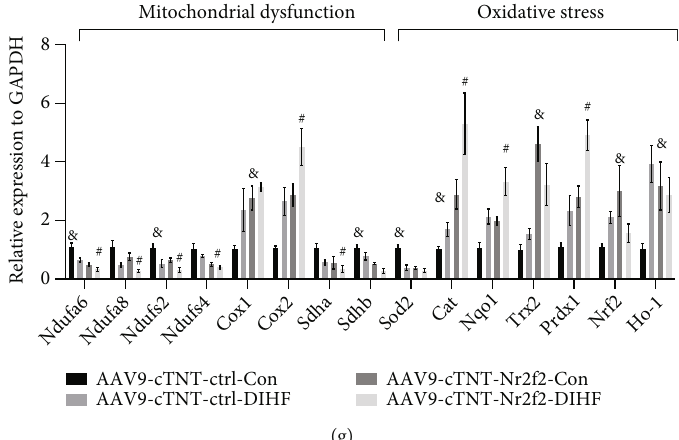
Figure 2: Overexpression of Nr2f2 aggravated cardiac ferroptosis. (a) Representative Western blot of PTGS2 and GPX4 ( n = 4 , means ± SDs , ∗ p < 0 : 05 and ∗∗∗ p < 0 : 005 , ns: not signi fi cant, two-way ANOVA). (b) 4-HNE staining (scale bar = 50 μ m ) and mitochondrial transmission electron microscopy (scale bar = 2 μ m ) were identi fi ed in the heart tissue. (c – e) Tissue MDA, GSH, and SOD levels in each group ( n = 6 , means ± SDs , ∗ p < 0 : 05 and ∗∗∗ p < 0 : 005 , two-way ANOVA). (f) Total iron level in each group ( n = 6 , means ± SDs , ∗∗ p < 0 : 01 and ∗∗∗ p < 0 : 005 , two-way ANOVA). (g) Relative gene expression of mitochondrial function and oxidative stress ( n = 6 , means ± SDs , ∗∗ p < 0 : 01 and ∗∗∗ p < 0 : 005 ; ns: not signi fi cant, two-way Con mice (Figures 1(a) and 1(b)). Nr2f2 overexpression (Figure 1(c)) had no e ff ect on fasting blood glucose and body weight in DIHF or Con mice (Figures 1(d) and 1(e)). Car- diac function, re fl ected by decreased EF and FS and increased LVDs and LVDd in heart tissue (Figures 1(f) – 1(i)), was signi fi cantly worse in AAV9-cTNT-Nr2f2-Con compared to AAV9-cTNT-ctrl-Con mice (EF%: 70 : 76 ± 11 : 20 vs. 55 : 46 ± 7 : 04 ; FS%: 40 : 72 ± 9 : 744 vs. 28 : 91 ± 4 : 592 ; LVDs: 2 : 447 ± 0 : 3412 vs. 3 : 208 ± 0 : 3517 mm ; and LVDd: 4 : 175 ± 0 : 536 vs. 4 : 509 ± 0 : 356 mm ), AAV9-cTNT-Nr2f2- DIHF compared to AAV9-cTNT-ctrl-DIHF mice (EF%: 47 : 09 ± 7 : 540 vs. 29 : 35 ± 4 : 800 ; FS%: 23 : 73 ± 4 : 612 vs. 13 : 78 ± 2 : 533 ; LVDs: 3 : 614 ± 0 : 2975 vs. 4 : 107 ± 0 : 1367 mm ; and LVDd: 4 : 737 ± 0 : 223 vs. 4 : 696 ± 0 : 216 mm ). In an aspect of structural staining, DIHF mice presented obvious cardiac hypertrophy and interstitial and perivascu- lar fi brosis compared with Con mice ( fi brosis area: 11 : 42 ± 2 : 458 vs. 5 : 170 ± 1 : 082 % ). Moreover, Nr2f2 overexpression had no impact on cardiac hypertrophy but exacerbated fi brosis in DIHF mice and the fi brosis area of the AAV9- cTNT-Nr2f2-Con group was larger than that of AAV9- cTNT-ctrl-Con group ( fi brosis area: 25 : 17 ± 2 : 843 vs. 19 : 37 ± 1 : 590 ) (Figures 1(f), 1(k), and 1(l)). Nr2f2 overexpression